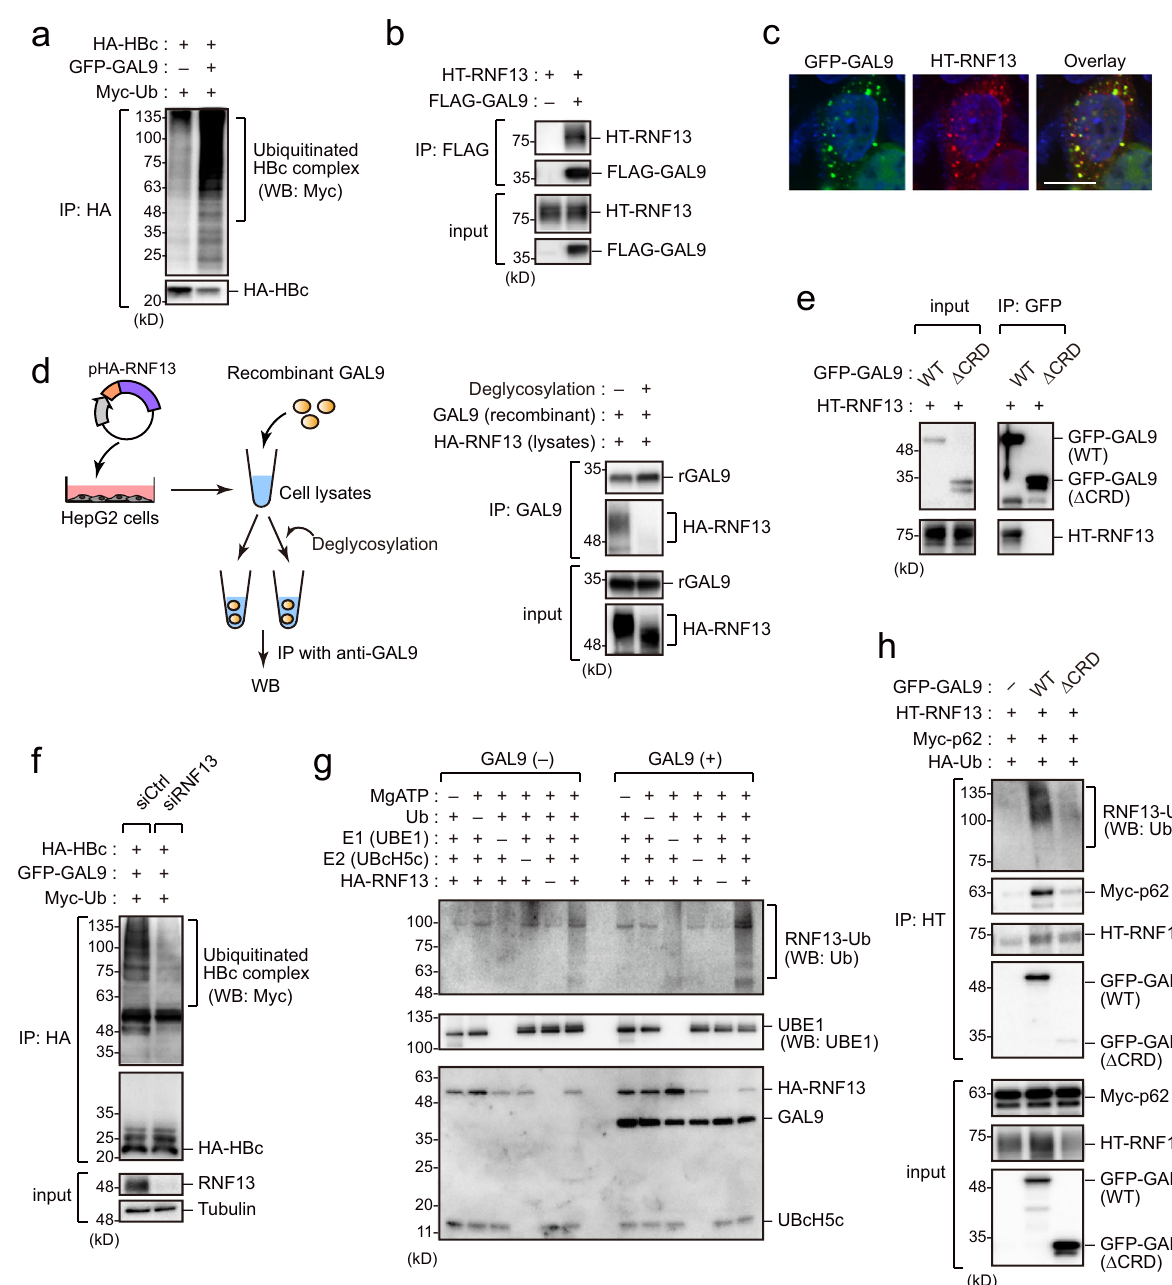
Fig. 5 RNF13 regulates GAL9/p62-mediated selective autophagy targeting HBc. a GAL9 induces HBc-complex ubiquitination. HepG2 cells expressing HA-HBc, GFP-GAL9, and Myc-Ubiquitin (Ub) were pulled down with anti-HA antibody, and the pulldowns were analyzed by immunoblotting. b GAL9 interacts with RNF13. Immunoprecipitation assay was performed on HepG2 cells expressing FLAG-GAL9 and HT-RNF13. Cell lysates were precipitated with anti-FLAG antibody, followed by immunoblotting. c Confocal microscopic imaging of HepG2 cells expressing GFP-GAL9 and HT-RNF13. Nuclei were stained with DAPI. Scale bar, 10 µ m. Another view of the cell image is shown in Supplementary Fig. 6b. d Glycosylation of RNF13 is required for GAL9 interaction. HepG2 cells expressing HA-RNF13 were immunoprecipitated with anti-HA. The immunoprecipitates were incubated with recombinant GAL9 in the presence or absence of Protein Deglycosylation Mix II (5 units/ µ L) and then pulled down with GAL9 antibody for immunoblotting. e GAL9 CRD binds to RNF13. Immunoprecipitation assays of HepG2 cells expressing GAL9 CRD-deleted mutant and HT-RNF13. Cell lysates were precipitated with anti-GFP antibody, followed by immunoblotting. f RNF13 is a cofactor for ubiquitination of HBc complex. HepG2 cells expressing HA-HBc, GFP-GAL9, and Myc-Ub. Cells were transduced with siRNA targeting RNF13 at 24 h prior to DNA transfection. Cells were then immunoprecipitated with anti-HA antibody and subjected to immunoblotting. g Ubiquitination of RNF13 is increased by GAL9. HepG2 cells expressing HA-RNF13 were immunoprecipitated with anti-HA. The immunoprecipitates were incubated with indicated recombinant proteins in the presence or absence of GAL9 for 1 h. Samples were then electrophoresed and the gel was subsequently processed for CBB staining or immunoblotting with anti-Ub and UBE1 antibodies. h CRD-deleted GAL9 does not enhance the auto-ubiquitination of RNF13 and p62 recruitment. HepG2 cells expressing indicated proteins were precipitated with anti-HT antibody, followed by immunoblotting. Immunoblots and micrographs are representative of experiments with similar results ( n ≥ 2). Source data are provided as a Source Data fi